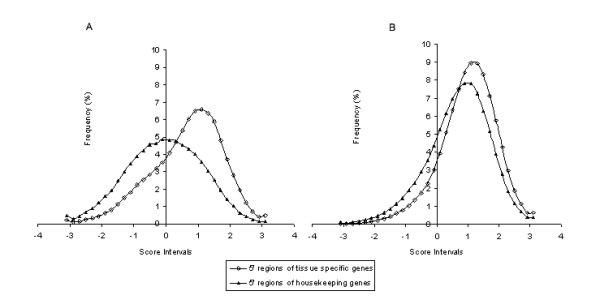
Nucleosome formation potential score distributions for 5' regions of housekeeping and tissue specific genes. The 5' sequences of human housekeeping and tissue specific genes were analysed by Recon for distribution of nucleosome formation potential scores. Frequency distribution histograms were plotted for scores in various intervals (range -3.2 to +3.2). (A) and (B) show the distribution of nucleosome formation potential scores at 400 and 2000 bp upstream from the gene start site respectively. Nucleosomal density is significantly lower for housekeeping genes as compared to tissue specific ones, in regions close to the gene start site.